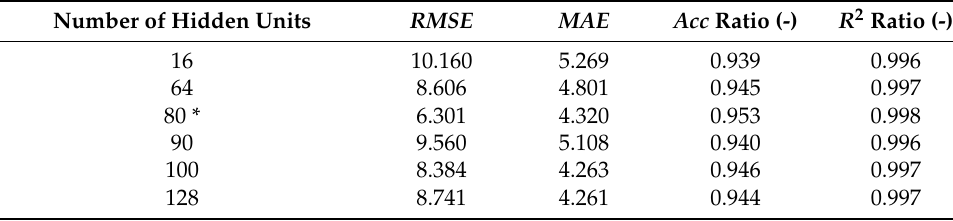
Table 1. Performance comparison of the number of hidden